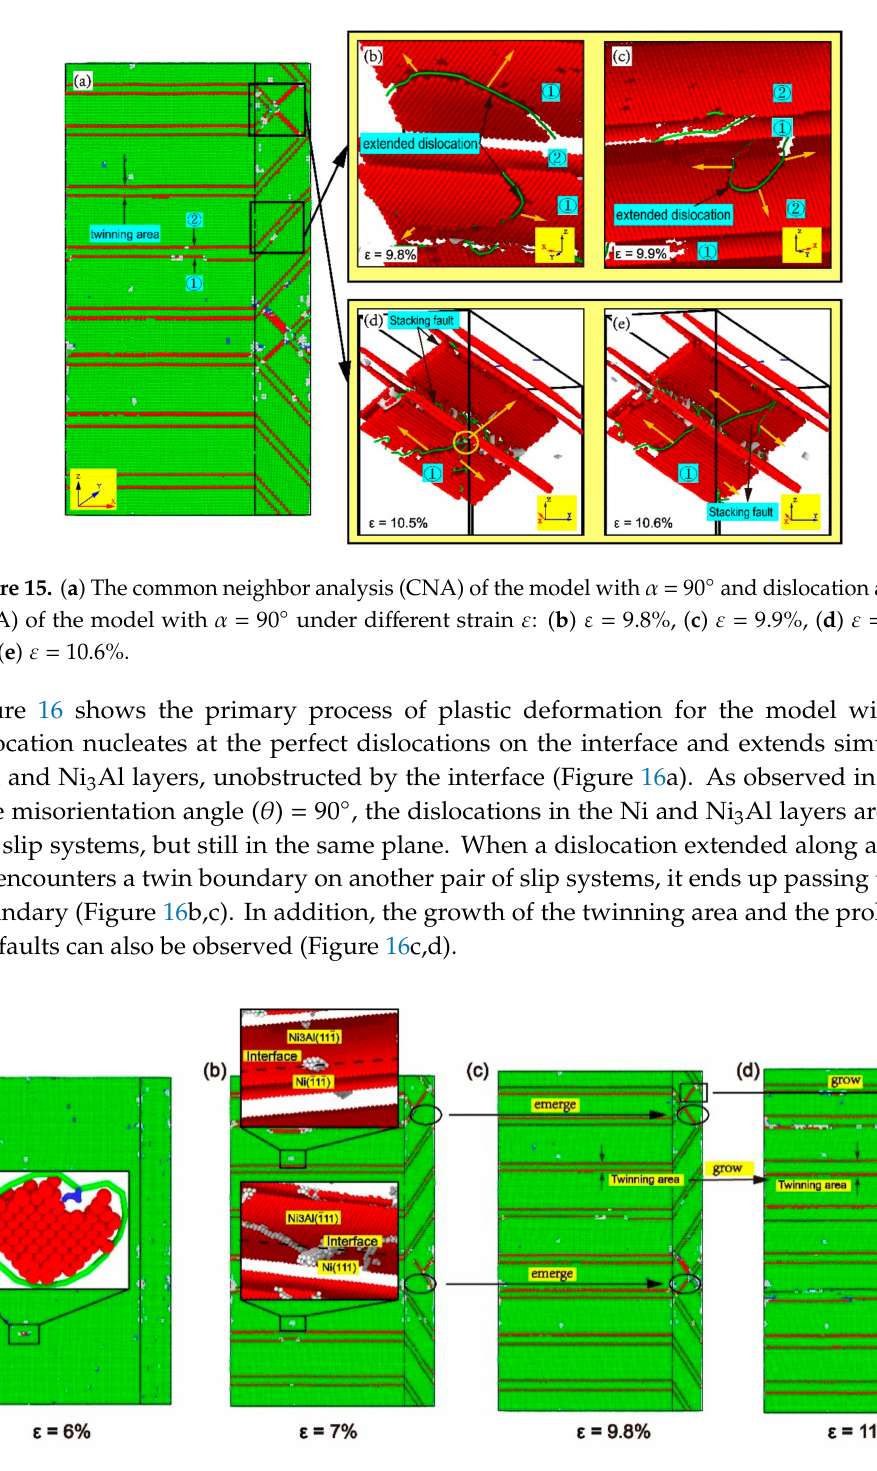
Figure 16. The common neighbor analysis (CNA) of the model with α = 90 ◦ under di ff erent strains ε : ( a ) ε = 6%, ( b ) ε = 7%, ( c ) ε = 9.8%, and ( d ) ε =